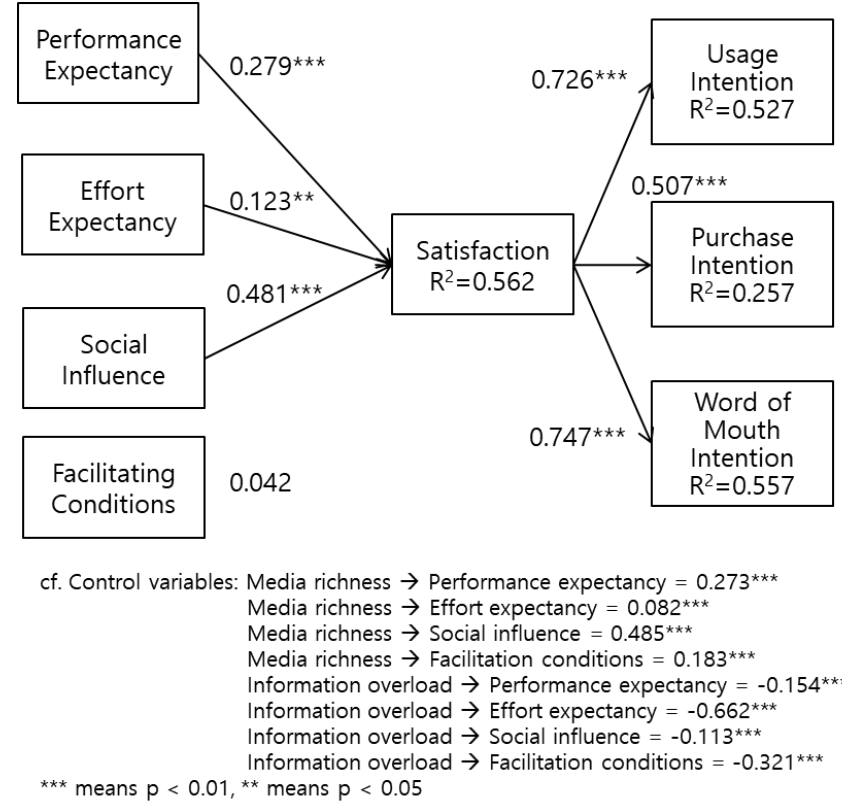
Figure 2. PLS analysis results.